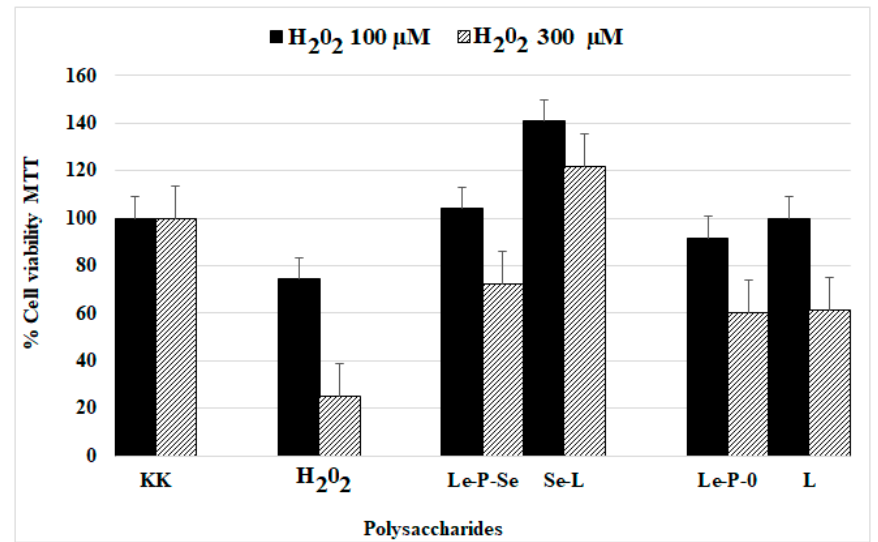
Figure 13. Comparison of the protective effect of exopolysaccharides isolated from the culture medium (selenated fraction Le-P-Se and non-selenated fraction Le-P-0) and polysaccharides extracted from the mycelial biomass (selenated—Se-L and not selenated L) [25] on exogenous oxidative stress induced by hydrogen peroxide in concentrations of 100 and 300 µM. KK—control; H 2 O 2 —control cells H 2 O 2 treated. The data represent the mean ± S.D of 4 observations.